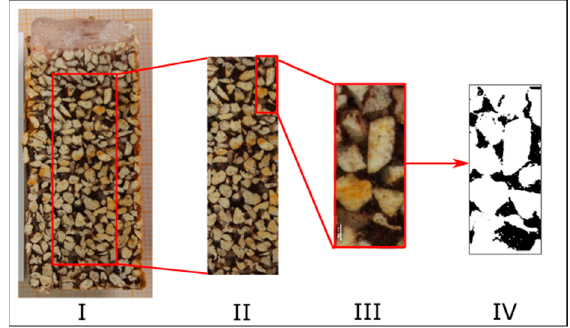
Figure 1. Picture analyses with ImageJ with ( I ) photograph of the frozen and cut column, ( II ) core excluding wall effects, ( III ) subsection (1 of 12) and ( IV ) converted binary image.